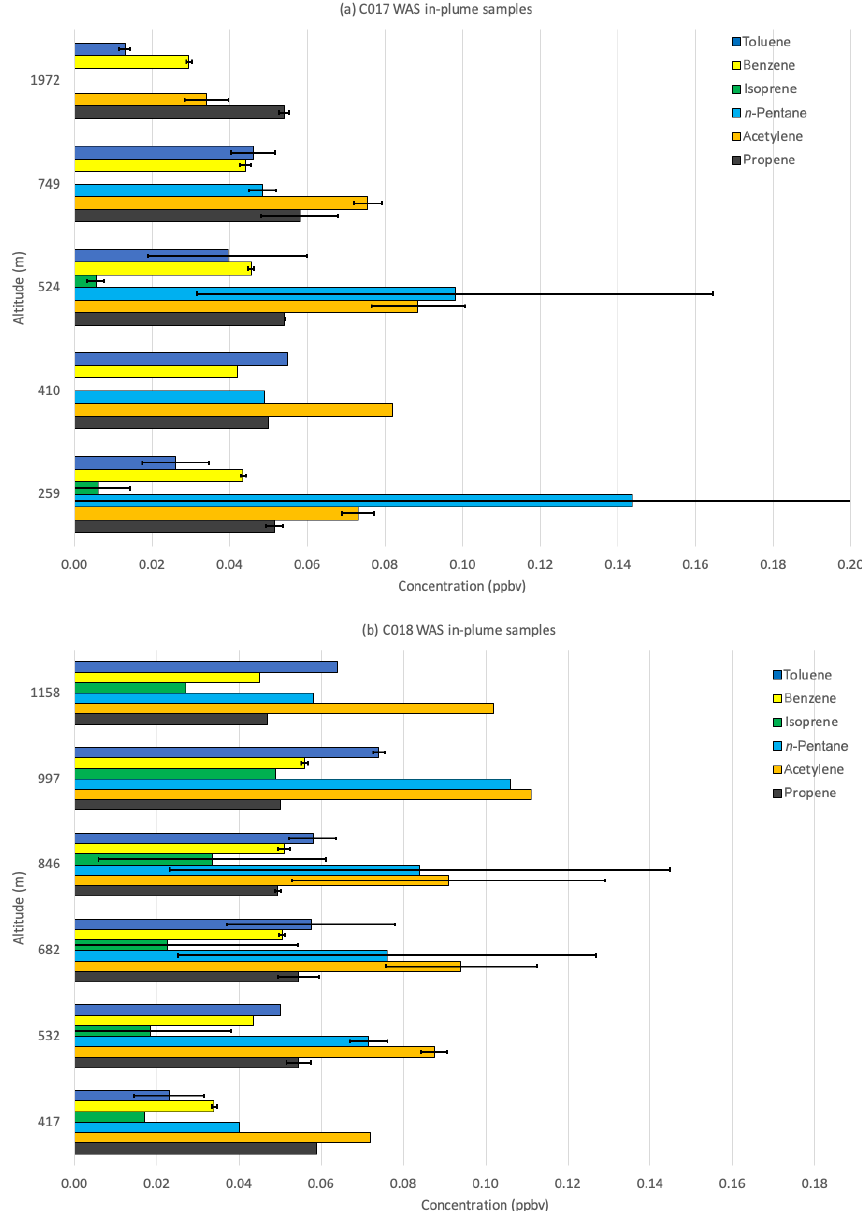
Figure 12. Average concentrations of key VOCs (ppbv) collected via WAS during individual flight legs within the pollution plume detected during (a) flight C017 and (b) flight C018. The average altitude of each flight leg is shown on the y axis. Error bars denote ± 1SD; numbers in square parentheses show the top of error